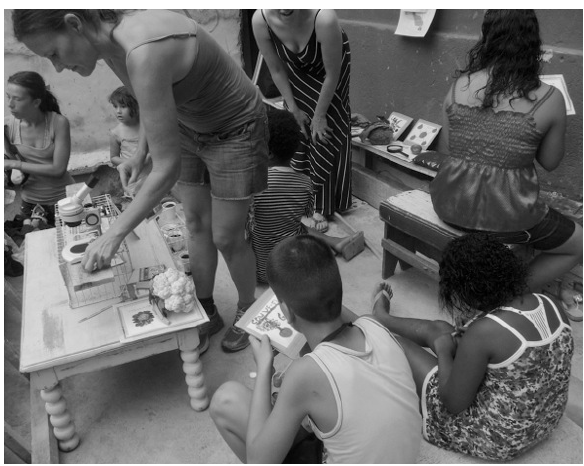
Figure 8. Children’s workshop at Rocinha Mais Verde